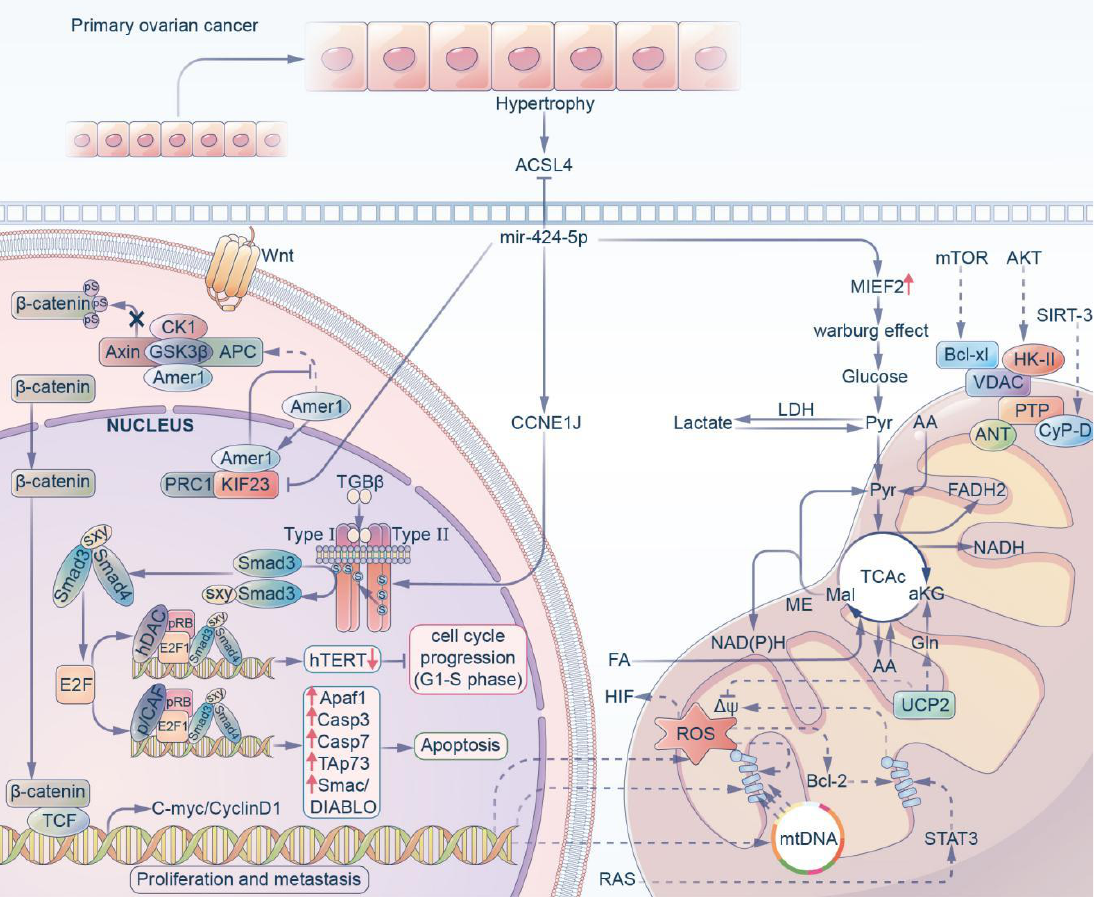
Figure 3. MiR-424-5p can regulate ovarian cancer progression in 4 different ways. (i) MiR-424-5p can inhibit ACSL4 to prevent hypertrophy of primary ovarian cancer. (ii) MiR-424-5p decreases the expression of KIF23 to inhibit the proliferation and migration of ovarian cancer. (iii) MiR-424-5p targets CCNE1J directly to activate the E2F1-pRb signaling pathway, which results in an antitumor effect. (iv) MiR-424-5p increases the expression of MIEF2 to facilitate the Warburg effect.